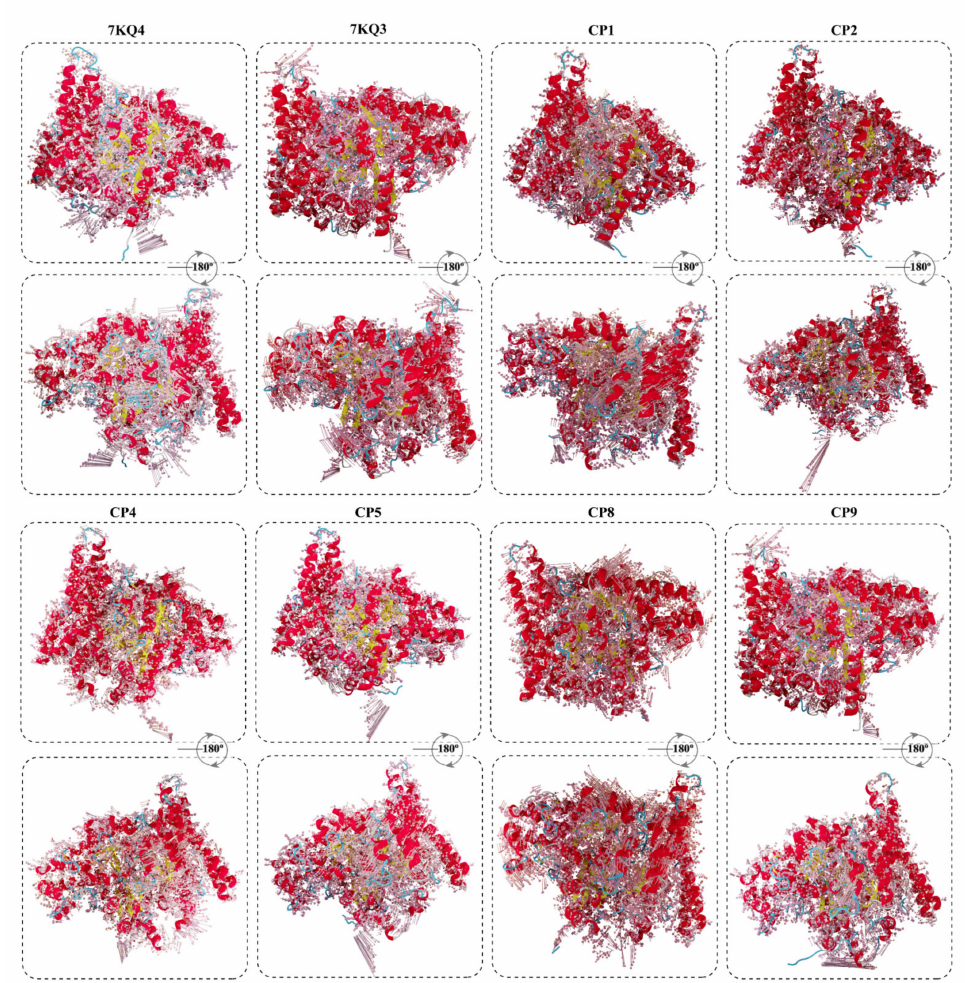
Figure 7. Principal motions of the Isla obtained from the principal component analysis (PCA) in free state (7KQ4), substrate-bound Isla (7KQ3), and inhibitors bound states. The length of the arrow represents the magnitude of the motion, and direction of the motion is denoted by the